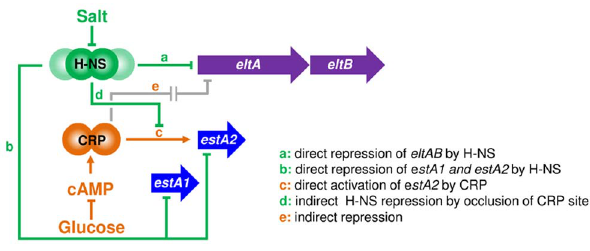
Fig. 10. An osmo-metabolic gene regulatory circuit comprised of CRP and H-NS controls expression of LT and ST. The diagram illustrates the regulatory effects of salt, cAMP and glucose on transcription from the various ST and LT promoter